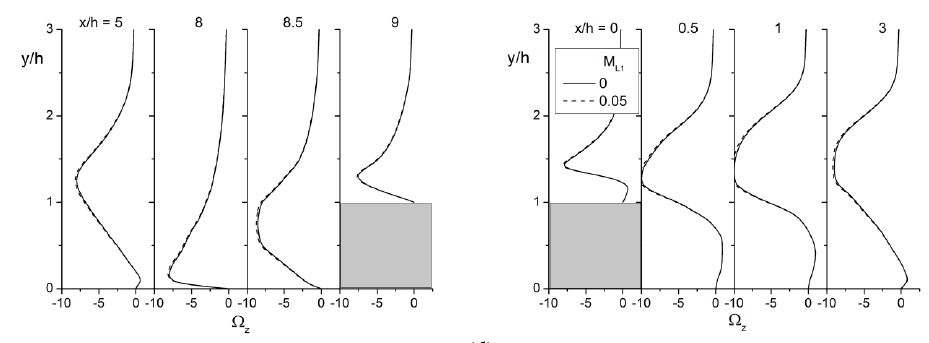
Figure 7. Transverse profiles of averaged streamwise velocities ( a ), turbulent kinetic energy ( b ), and gas-phase temperature in a single-phase flow ( M L 1 = 0), a gas-droplet flow at M L 1 = 0.05, and liquid drops ( c ) as well as vorticity ( d ). Re = 1.6 × 10 4 , h / H = 0.1, p / h = 10, d 1 = 15 μm, M L 1 = 0.05.